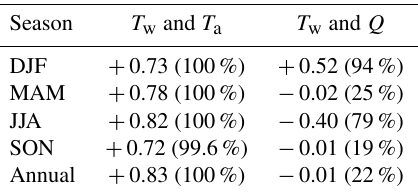
Table 2. Pearson correlation over the 1963–2019 period between seasonal and annual T w and T a and/or Q time series, averaged over all reaches. Percentages in brackets show the proportion of reaches with a significant correlation at the 95% confidence